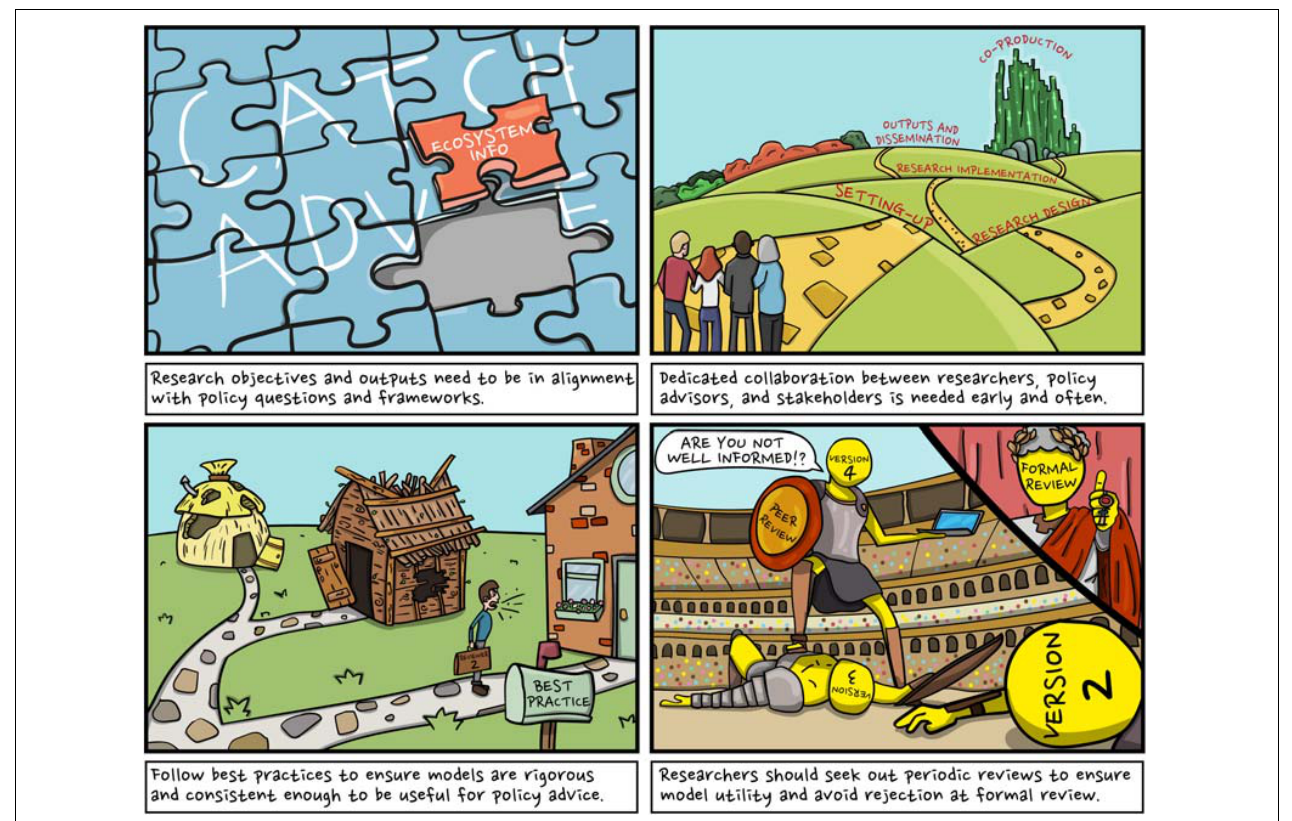
FIGURE 10 | Preparing ecosystem models for policy advice. Drawing on the experience of WKIrish, these illustrations outline the four key lessons which have been fundamental in our pursuit to operationalize the Irish Sea EwE model for policy